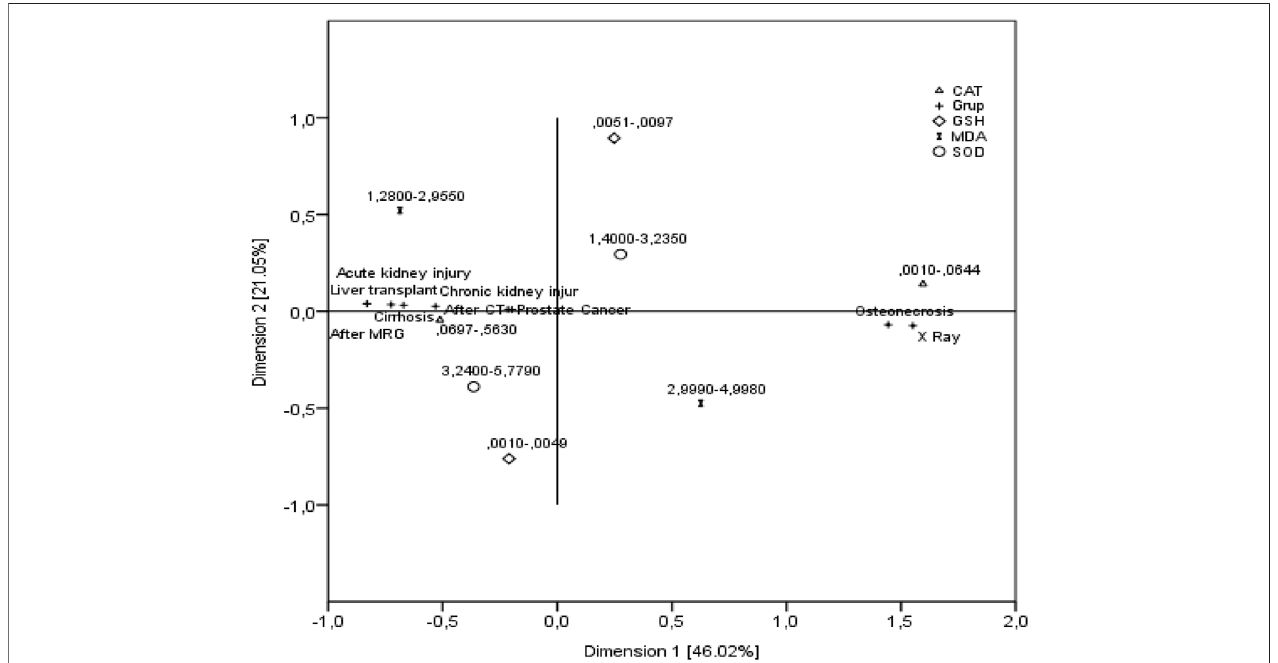
FIGURE 5 | Con fi guration of groups and biochemical features in two-dimensional